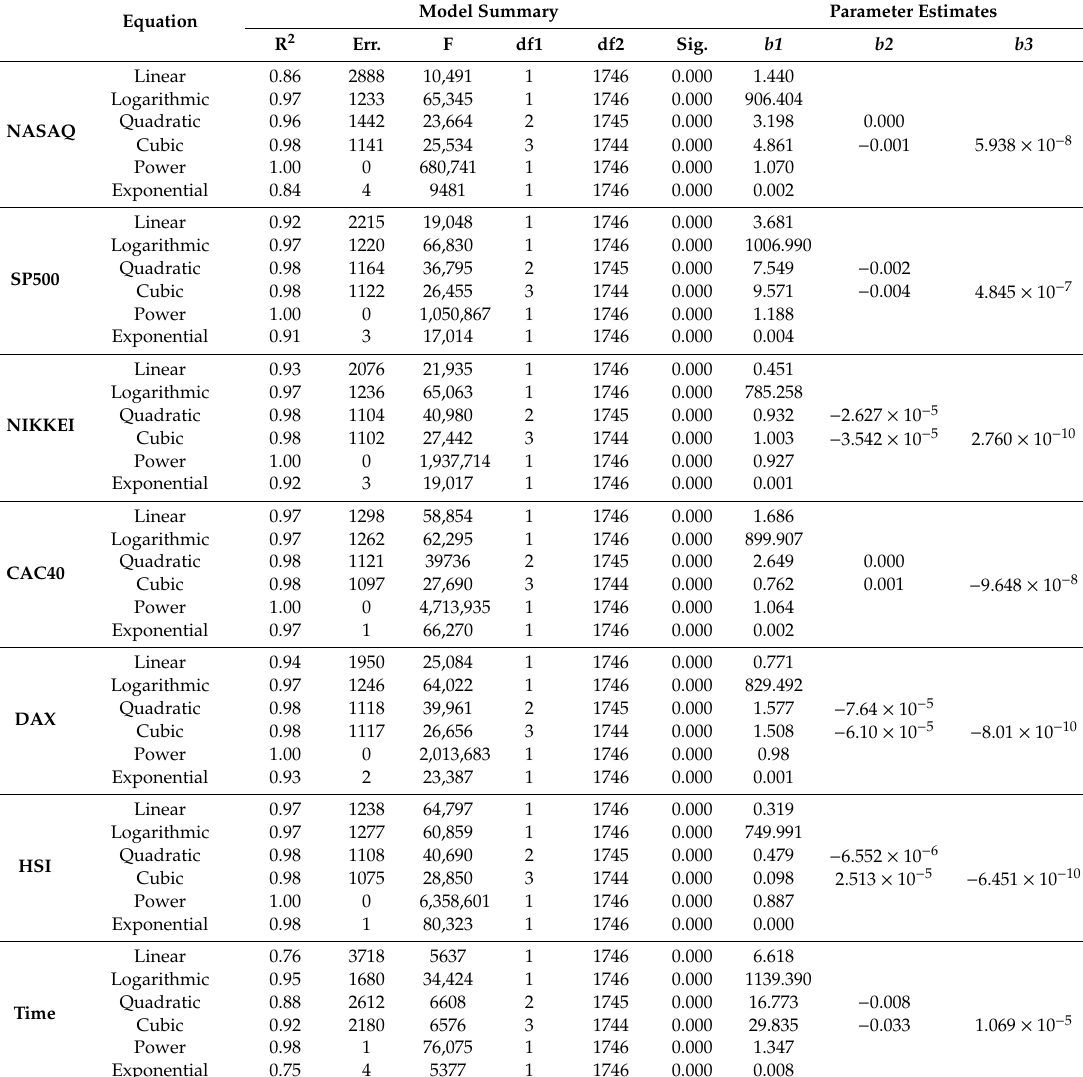
Table 4. Estimating the TASI using linear, logarithmic, quadratic, cubic, power, and exponential